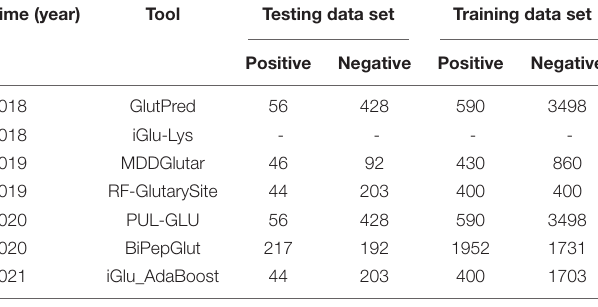
TABLE 3 | The number of positive and negative samples in the training and testing data sets.